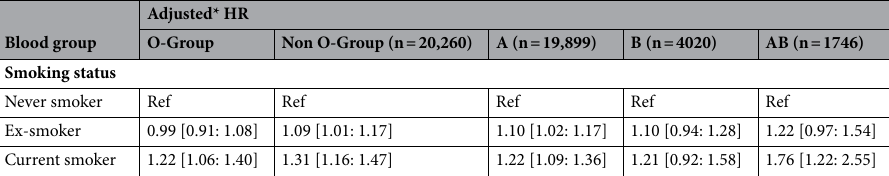
Table 3. Risk of incident dyslipidaemia depending on smoking status, stratified by blood ABO group, hazard ratios (HR) estimated from Cox proportional hazards models. *Adjusted for body mass index, physical activity, education level, diabetes, hypertension, family history of cardiovascular disease, use of menopausal hormone therapy, and age at menopause. Age as the timescale. Considering dyslipidaemia validated by medication